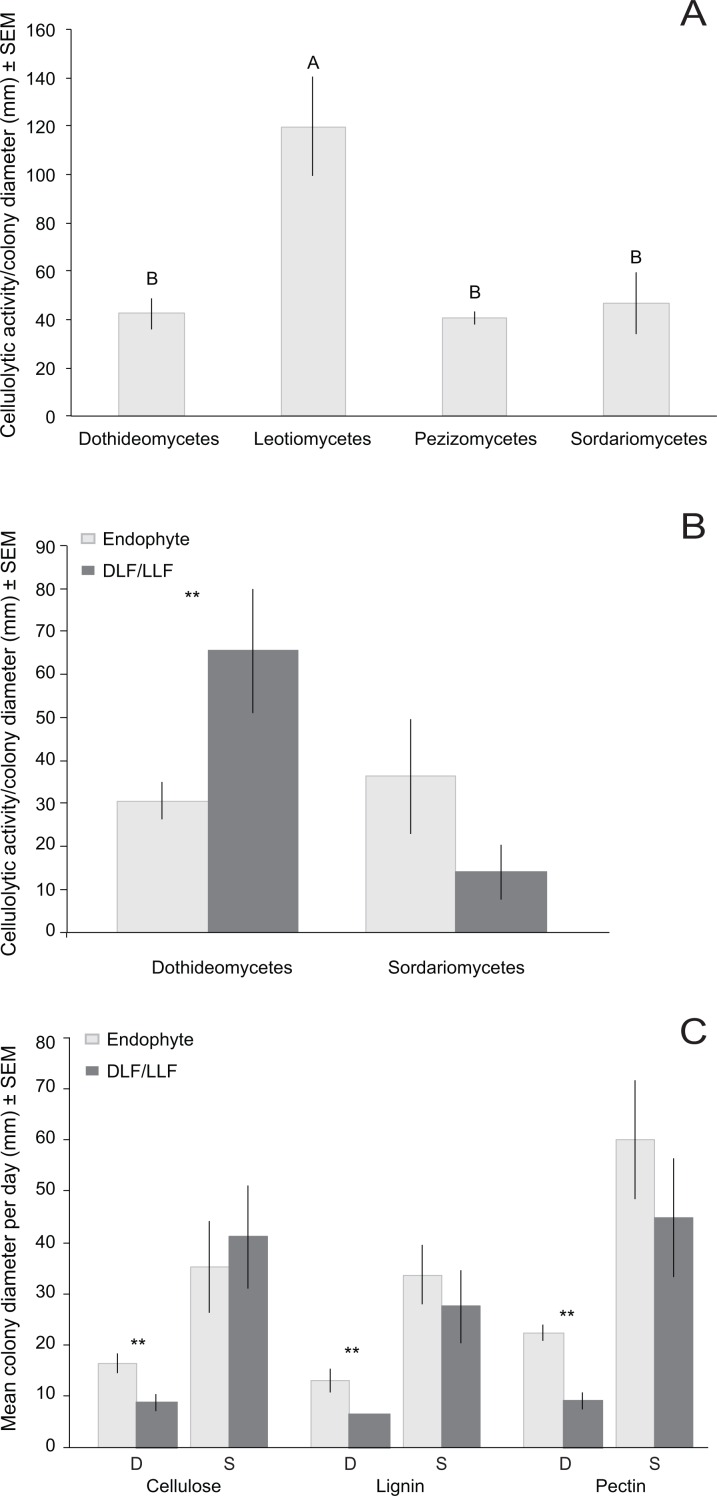
Normalized in vivo cellulolytic activity (mean activity/colony diameter) and growth (mean colony diameter/day) of 17 representative fungal OTU isolated from living (i.e., endophyte) and non-living leaves (DLF/LLF).(A) Mean cellulolytic activity as a function of class-level taxonomy and (B) class-level taxonomy and leaf type. (C) Mean growth rate as a function of both class-level taxonomy (S, Sordariomycetes; D, Dothideomycetes) and carbon source (cellulose, lignin, or pectin). Different letters represent significant differences in enzyme activity as a function of fungal class after post-hoc nonparametric multiple comparisons (A). Asterisks (**) indicate significant differences in cellulolytic activity or growth between fungal OTU found only in non-living leaves vs. fungal OTU isolated from only living leaves (P < 0.05; Table S3) (B and C). No significant differences were observed between OTU of Sordariomycetes from different leaf types (Table S3) (B and C).